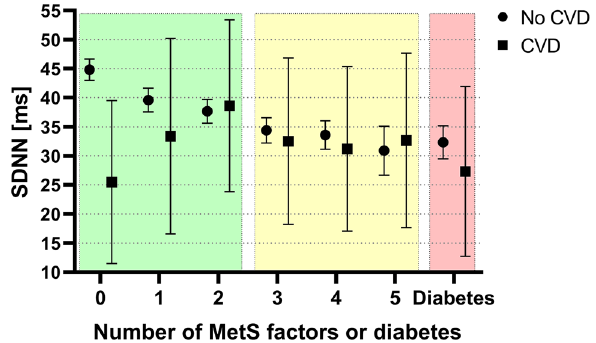
Figure 4. Mean and 95% confidence intervals of SDNN from the pre-CPT period for participants having different numbers of metabolic syndrome components or diabetes, stratified on CVD status. Green area represents healthy subjects and yellow area represents subjects with metabolic syndrome according to current definitions. Only 636 participants had known CVD, resulting in wider confidence intervals compared to the group without